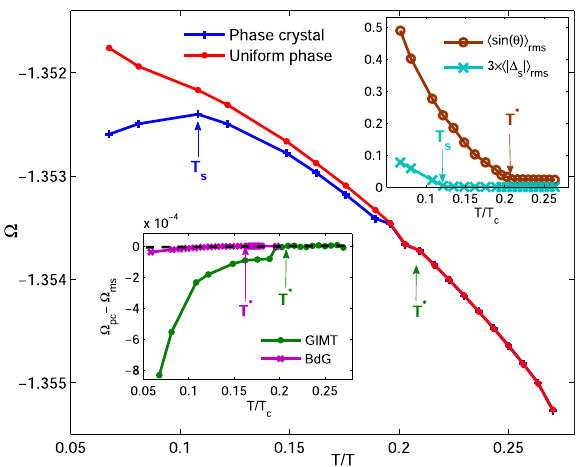
Fig. 2 Thermodynamics for clean sample. Free energy Ω calculated in GIMT for phase crystal and uniform phase states as a function of scaled temperature T / T c , where T c is the d -wave superconducting transition temperature. Green arrow indicates the phase crystal transition temperature T * . Upper inset shows the phase transition temperatures T * and T s obtained by plotting and the magnitude of the extended s -wave the phase h sin ð θ Þi rms pairing amplitude h Δ s j ji , respectively, averaged along the [110] rms edge (a very small temperature-independent value of Δ s of the uniform phase state has been subtracted to extract T s ). Lower inset shows difference in free energy between the phase crystal state, Ω Ω pc , and the metastable uniform phase state, ms , within GIMT and BdG. The energy jump in GIMT near T = T * is mainly from the internal energy E g .